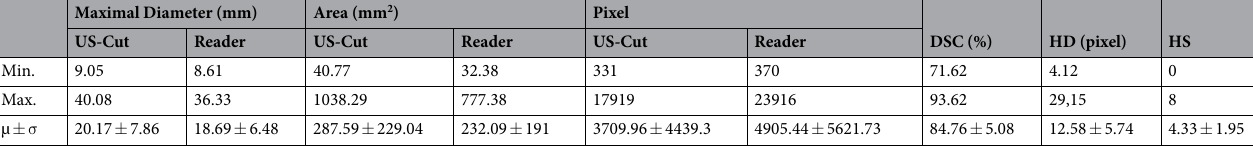
Table 1. Manual vs algorithmic (US-Cut) results for 40 cases of pancreatic cancer hepatic metastases: Dice Similarity Coefficient (DSC), Hausdorff Distance (HD), helper seeds (HS) 58 , mean value ( µ ) and standard deviation ( σ ).